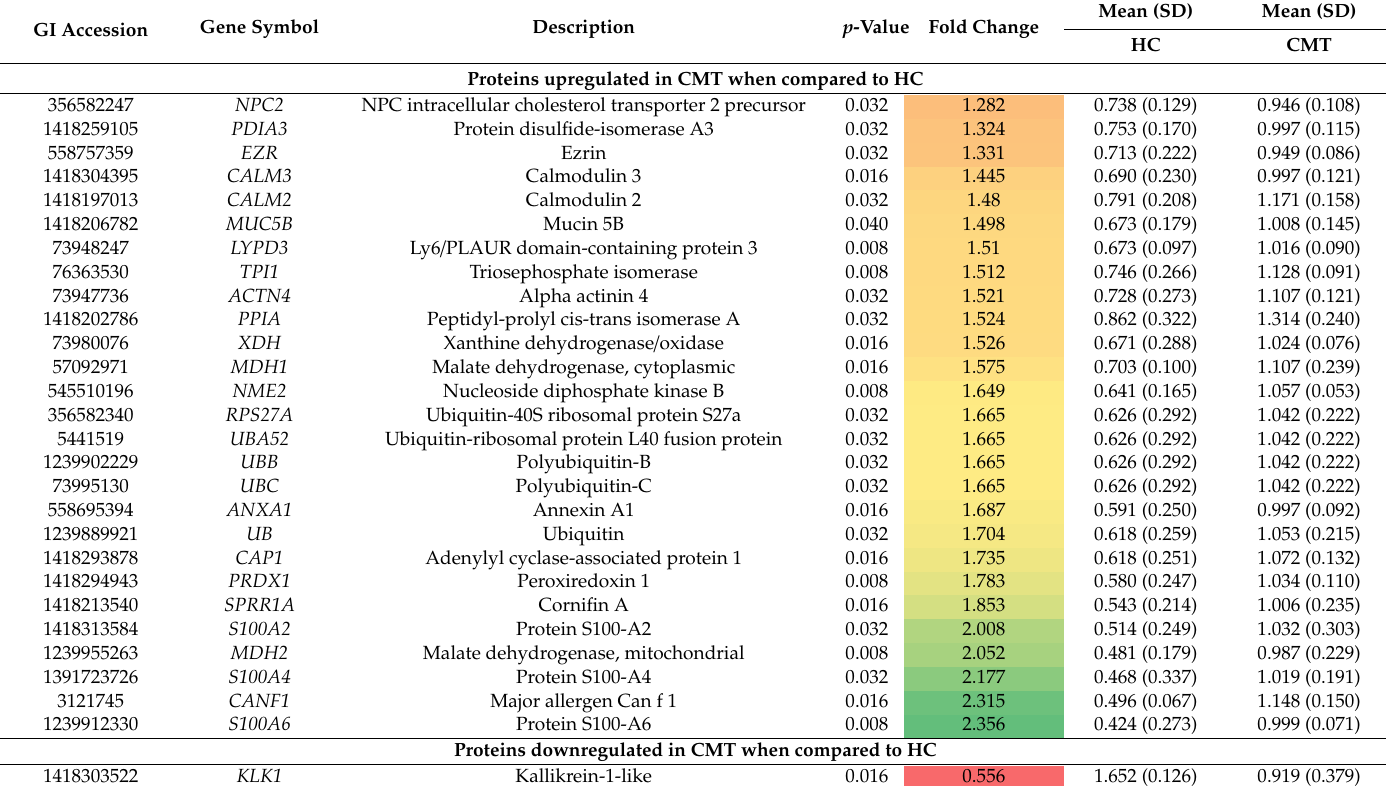
Table 3. Proteins downregulated and upregulated in saliva. In saliva, 49 proteins were initially identified with statistically significant di ff erent abundances in CMT and HC. After the removing of duplicates and isoforms, there were 27 upregulated and 1 downregulated